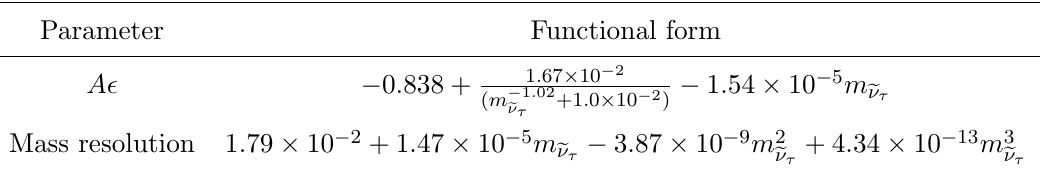
is given in units of GeV. The e (cid:23) (cid:28)